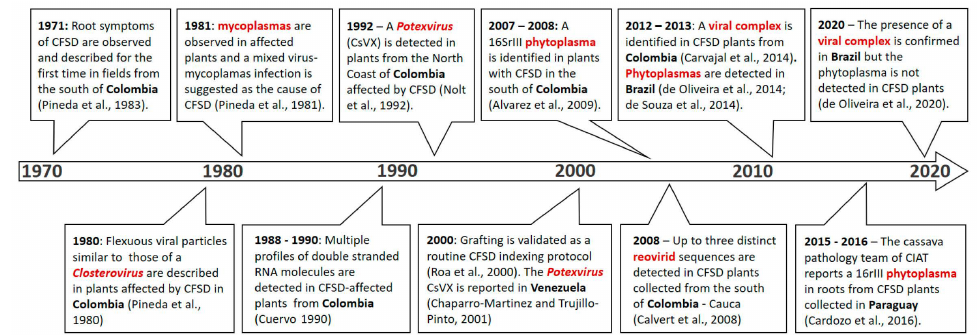
Figure 2. A timeline of the main results on the search for the causal agent of CFSD. Pineda et